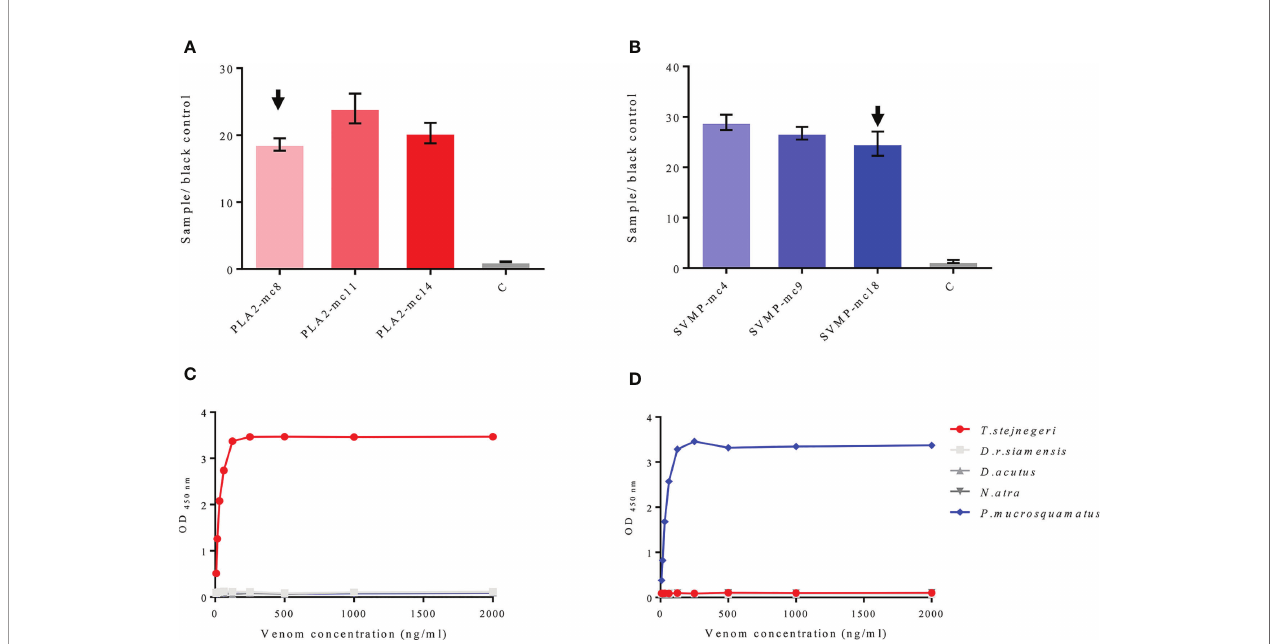
FIGURE 6 | Matching of mAbs-n and pAbs-n and testing on natural antigens. mAbs-n against PLA2-pep-3 and PLA 2 protein and mAbs-n against SVMP-pep-1 and SVMP protein were matched with anti-PLA 2 pAbs-n and anti-SVMP pAbs-n, respectively. pAbs-n with HRP-labeled mAbs-n as the detector antibody showed high OD 450 nm and low detection limit (7.81 ng/ml). Antibody matching of PLA2-mc8, PLA2-mc11, and PLA2-mc14 (positive mAbs-n to PLA2-pep-3 and PLA 2 ) with pAbs-n was successful (A) , with PLA2-mc8 showing the best matching effect (C) . In the antibody pairing test, SVMP-mc4, SVMP-mc9, and SVMP-mc18 (positive mAbs-n to SVMP-pep-1 and SVMP) matched well with pAbs-n (B) , with SVMP-mc18 showing the best matching effect (D)